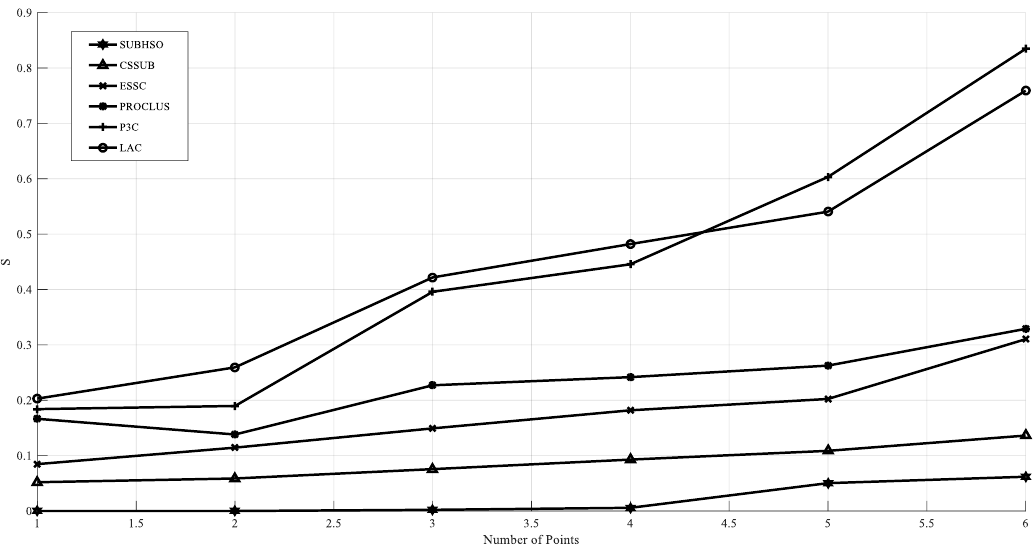
Fig. 12. Changes of variable S with increasing point